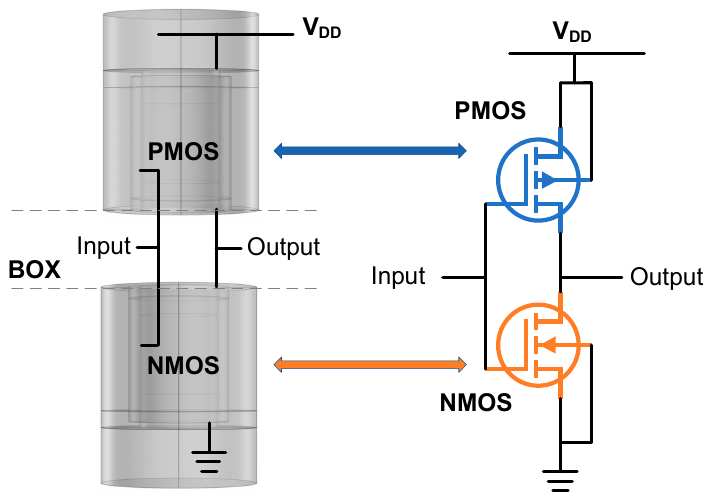
Figure 2. Schematic of 3-D inverter constructed by the proposed vertical MOSFETs for M3D ICs.